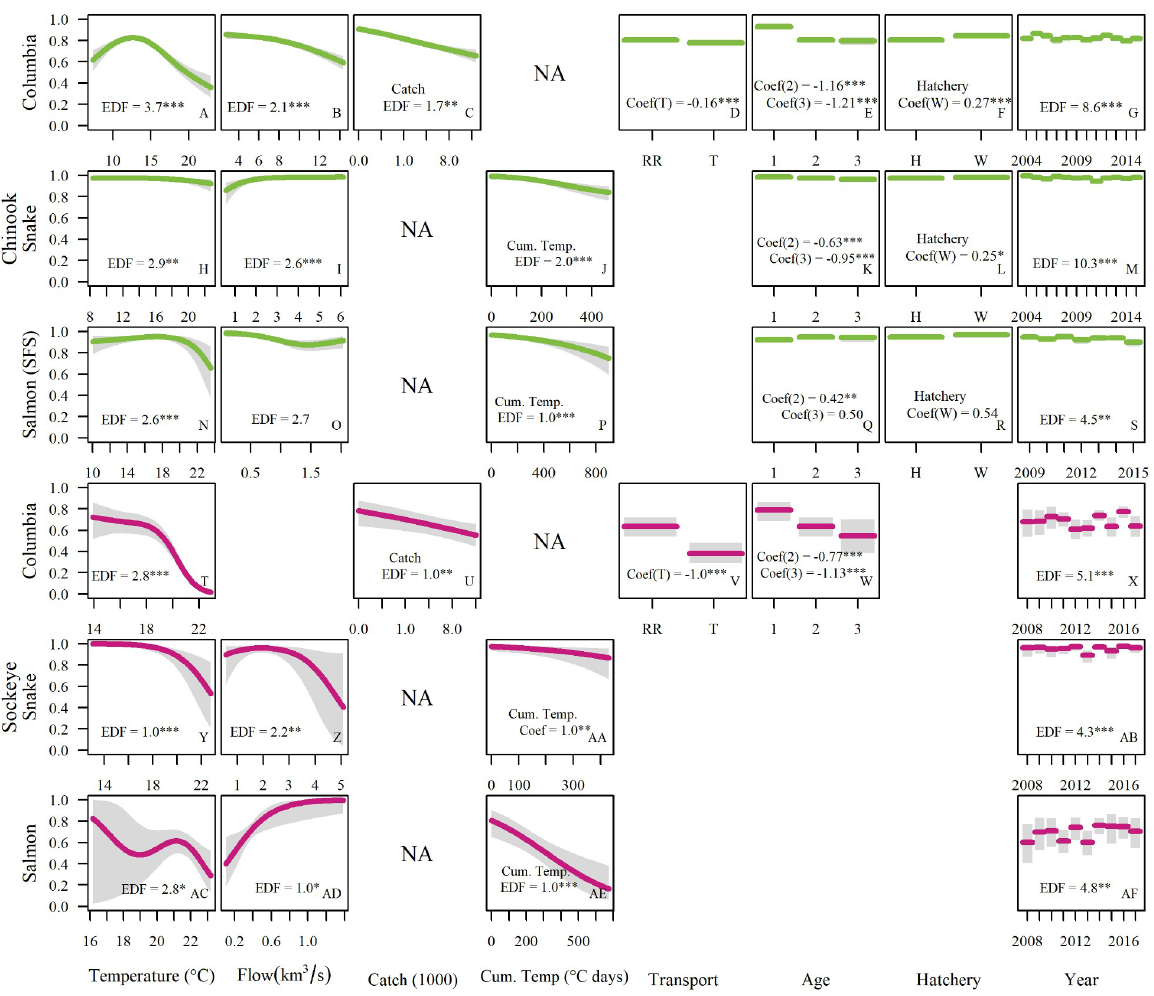
Fig 2. Main effects on predicted survival probabilities of the top migration survival model for each reach. The modeled effects of each variable are shown while other variables are set at their mean (continuous variables) or most common (factor variables) value. Estimated degrees of freedom (EDF) or coefficient values (Coef.) are shown for each variable (significance levels: � = P < 0.05, �� = P < 0.01, and ��� = P <